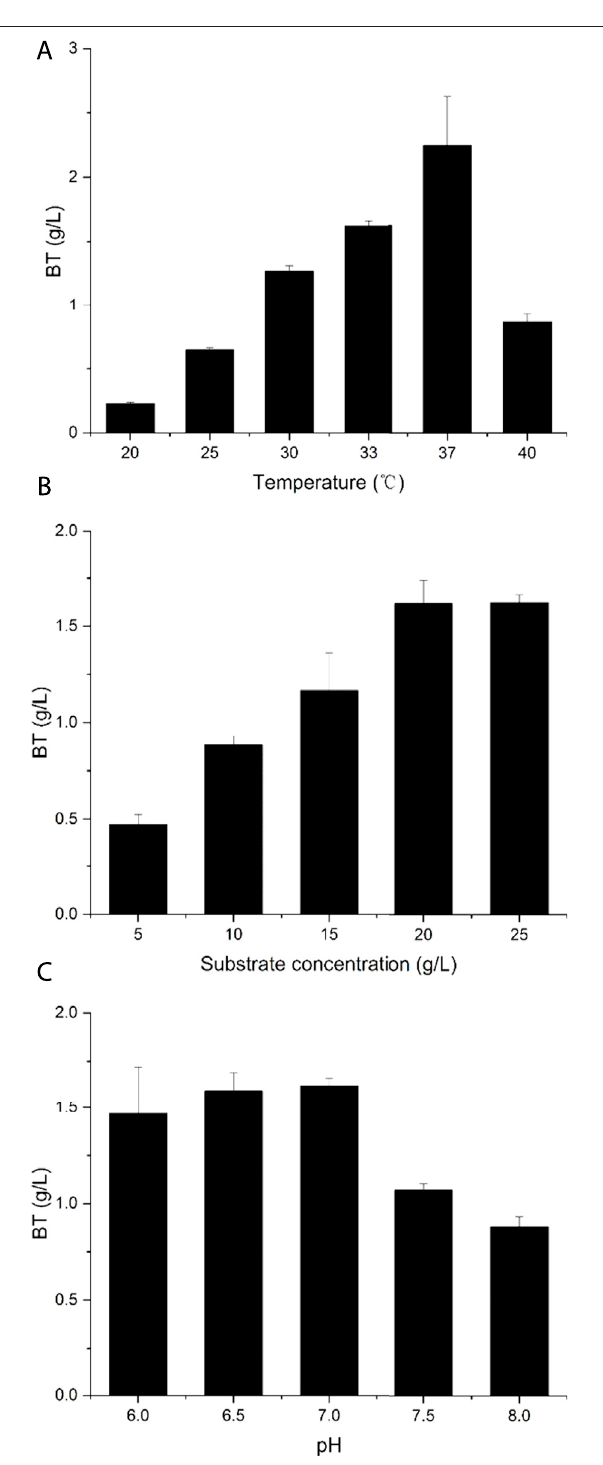
FIGURE 6 | Characterization of the recombinant strain BT5 Δ yiaE Δ ycdW Δ yagE. (A) The optimum catalytic temperature. (B) The optimum substrate concentration. (C) The optimum original reaction pH. The original catalytic conditions: reaction temperature was 33 ° C; substrate concentration was 20 g/L; reaction pH was 7.0. Each experiment only changes a single variable. Error bars represent SD ( n = 3).